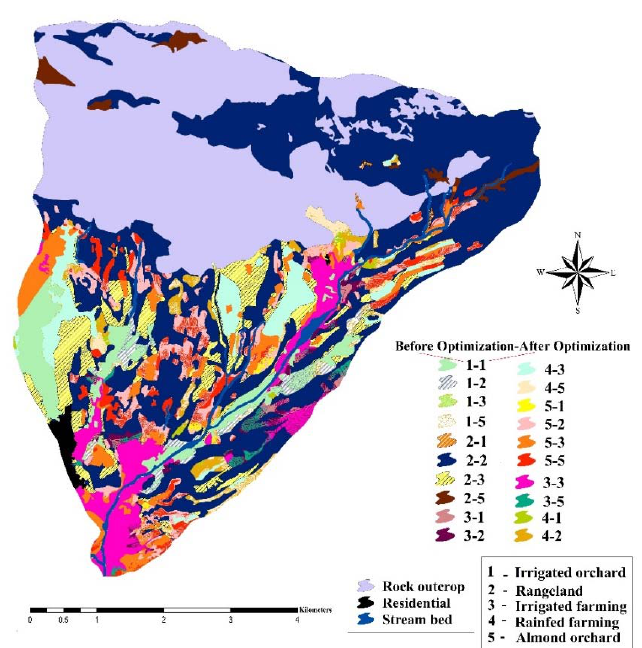
Fig. 8: Land use map (a) before and (b) after optimization